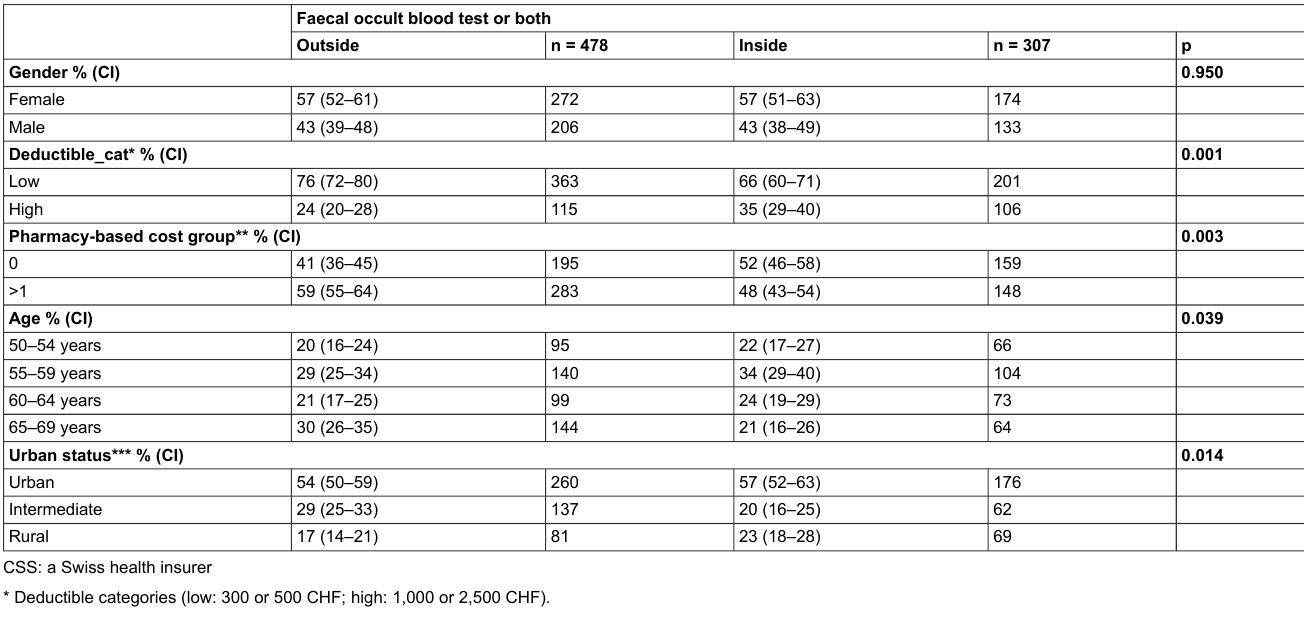
Table 3: Comparison of the proportion of faecal occult blood tests inside and outside the Vaud screening program, for insurees aged 50–69 years in 2018. CSS database. Statistical comparisons used the chi-squared test. Faecal occult blood test or